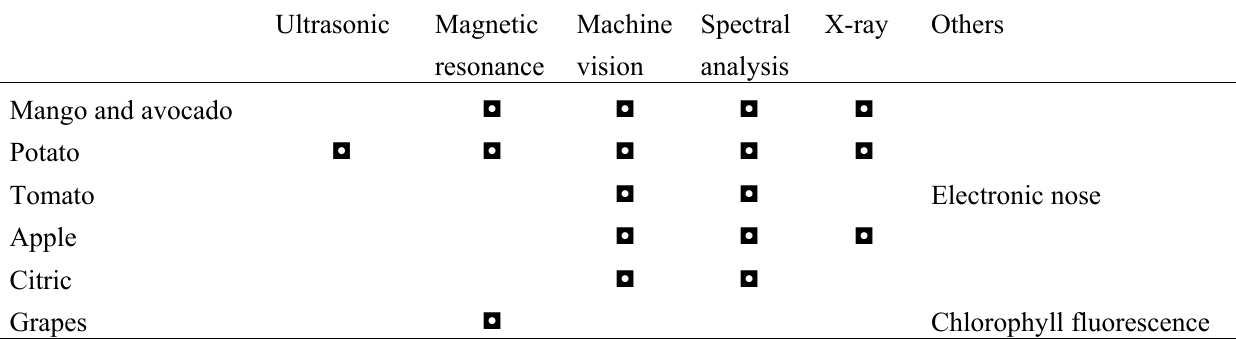
Table 2. Sensors used for post-harvest detection of diseases and